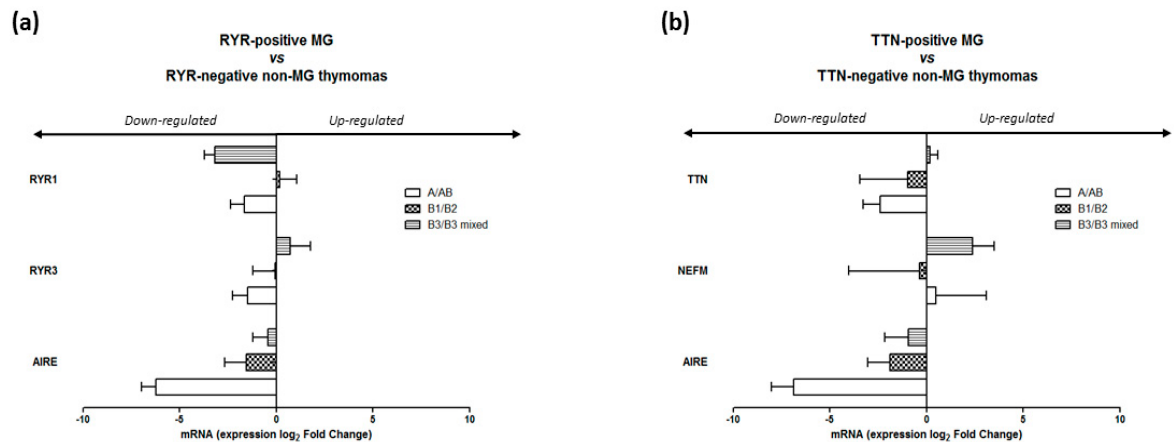
Figure 7. Altered expression of RYR1, RYR3 , and AIRE, and of TTN, NEFM , and AIRE in thymoma from MG patients positive for anti-RYR1 ( a ) and -TTN ( b ) autoantibodies compared to thymoma from seronegative non-MG patients. Data are presented as mean ± SEM of log2-fold change ratios of 2 −Δ Ct × 100 expression values in MG thymomas grouped based on WHO subtypes versus the same subtypes in the non-MG thymoma group .